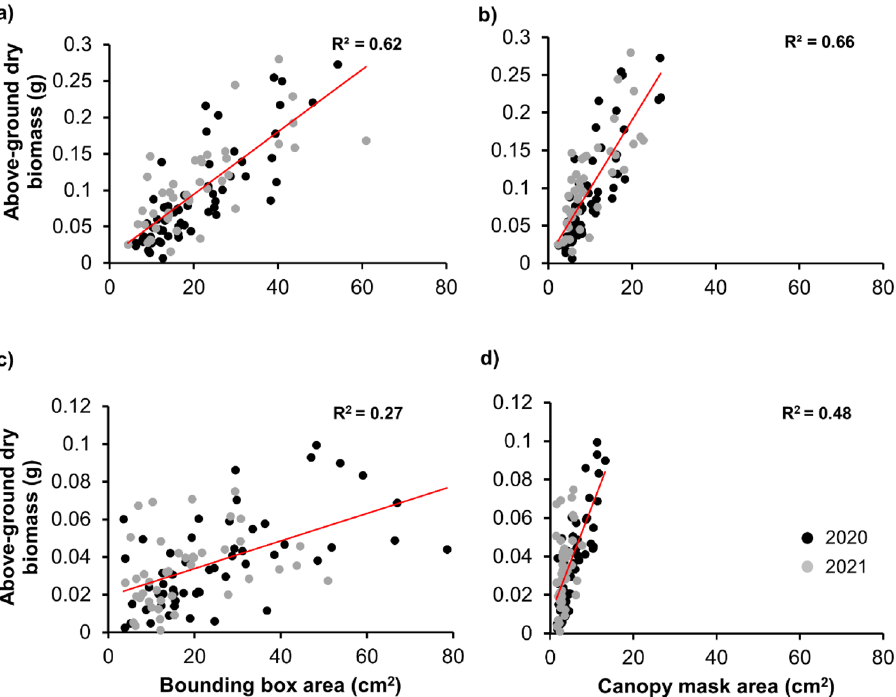
Figure 11. Regression analysis for estimating biomass for morninglories ( a , b ) and grasses ( c , d ) with bounding box and canopy mask area, respectively. The red line represents the best fitted line estimated by the regression analysis. Altogether, 99 (60 in 2020 and 39 in 2021) and 104 (60 in 2020 and 44 in 2021) MG and Grass individuals were sampled for biomass,